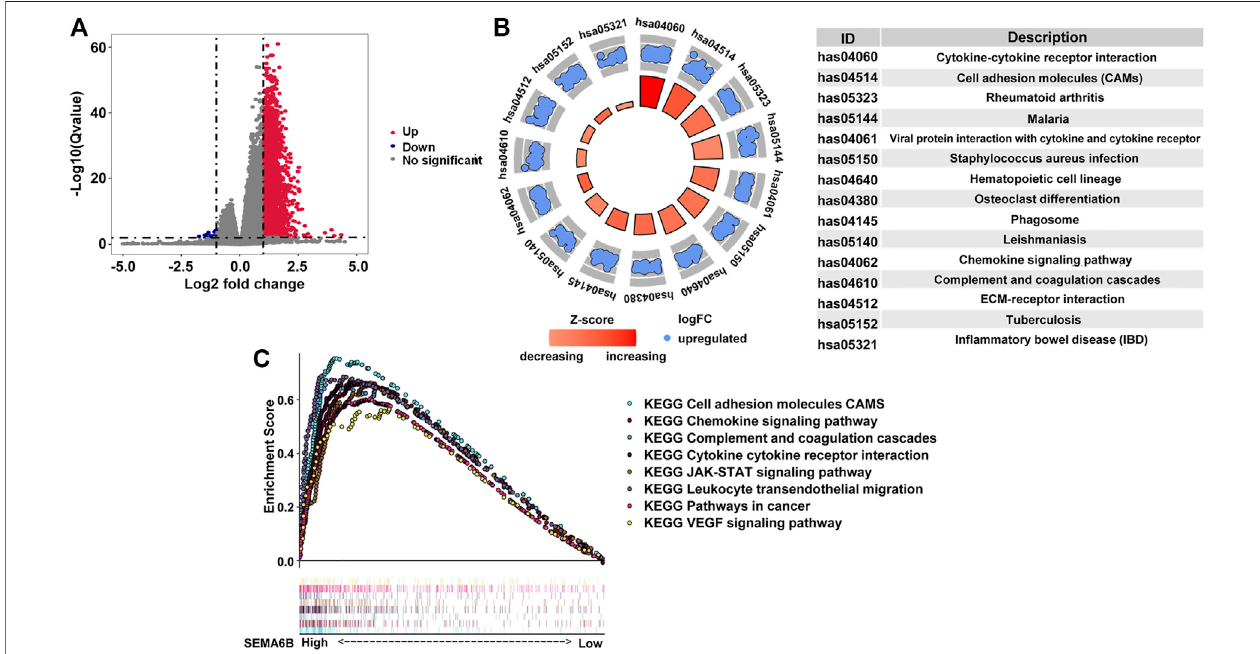
FIGURE 6 | Identi fi cation differentially expressed genes (DEGs) in CRC patients from the TCGA dataset as well as KEGG and GSEA pathway enrichment analysis. (A) Volcano plot of aberrantly altered gene pro fi les between high and low SEMA6B expression groups. A total of 1,794 DEGs were identi fi ed. The red dots (n (cid:2) 1,789) represent upregulated mRNAs, while the blue dots (n (cid:2) 5) refer to downregulated mRNAs. The x -axis indicates the log2-fold change in gene expression, and the y -axis denotes the adjusted p values plotted in − Log10. (B) Top-15 KEGG pathways enriched by the overexpressed DEGs in the high SEMA6B expression group. p valueswereadjustedbythefalse-discoveryrate(FDR) via Rsoftware.Thesizeofeachcircleindicatesthenumberofenrichedgenes,andthecolordenotestheadjusted p value. (C) GSEA enrichment plots of the TCGA-CRC dataset between high and low SEMA6B expression. A normalized enrichment score (NES) > 1 and adjusted p value (FDR) < 0.05 were used to determine signi fi cant gene